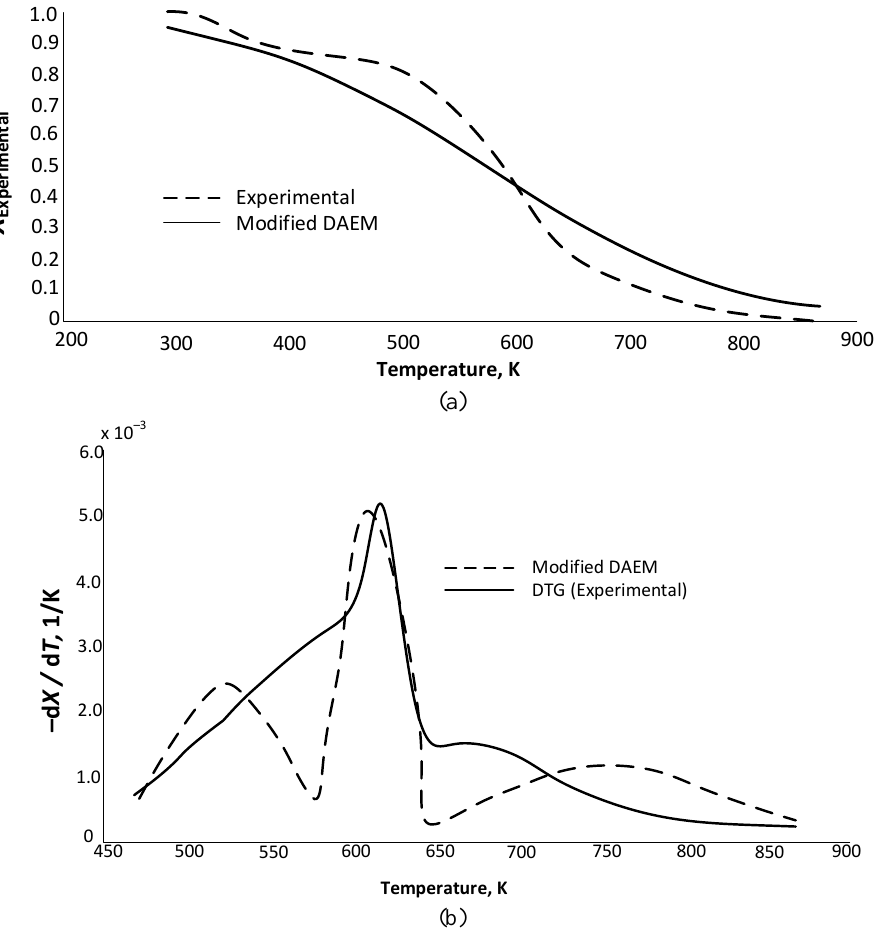
Fig. 6. Mathematical description of pine needles pyrolysis decomposition at 283 K/min by modified DAEM (a) integral; (b) differential. The modified model is capable to generate better results to describe the changes of mass loss with temperature, yet there are some visible deviations in the differential curve. Although in case of integral curve it is perfectly correlated with experimental data. After invoking it for